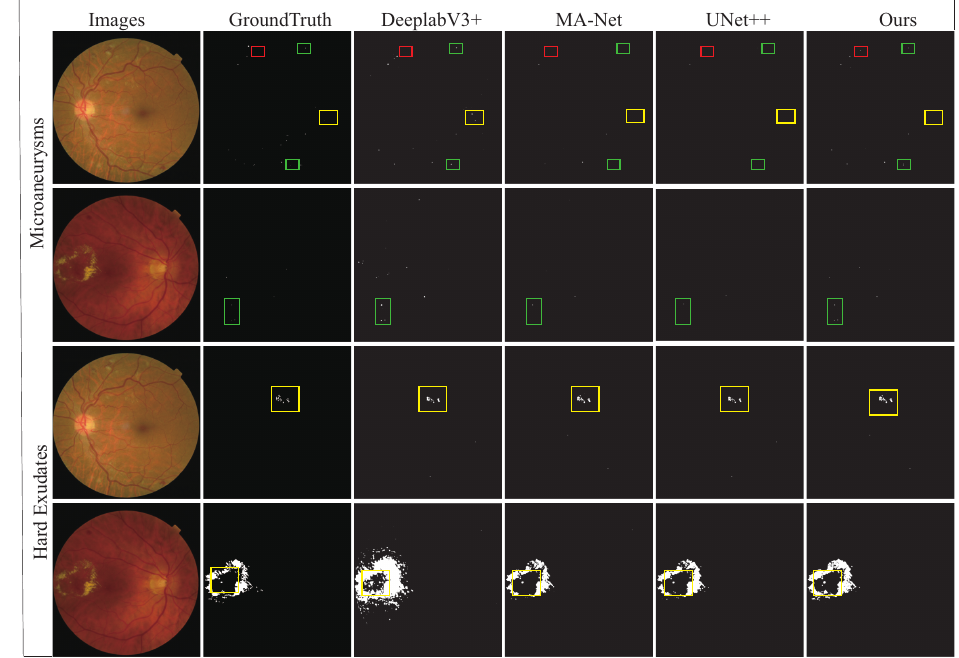
Figure 9. Illustration of fundus image with DR lesion. The rectangular box in the figure shows the comparison between the segmentation results of various methods and Ground Truth. The yellow boxes indicate that our method reduces the possibility of false detection compared with other methods, the green boxes indicate that our method reduces the possibility of false detection, while the red boxes indicate the error of our